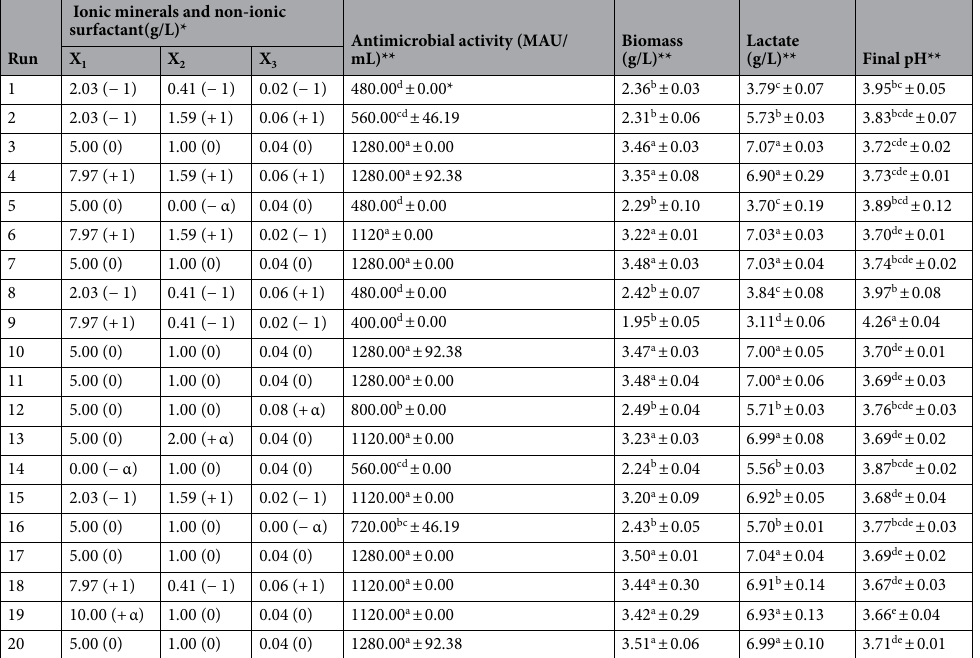
Table 6. CCD matrix with coded and real values of ionic minerals and non-ionic surfactant and their corresponding effects on the antimicrobial activity, lactate concentration and pH of postbiotic RS5, and biomass of L. plantarum RS5. *X 1 : Sodium acetate; X 2 : Tween 80; X 3 : manganese sulphate tetrahydrate. Coded values of medium components are indicated in parentheses. ** Values presented are mean ± standard error of the mean (SEM), n = 3. Mean ± SEM within the same column that does not share a similar superscript are significantly different (p < 0.05).